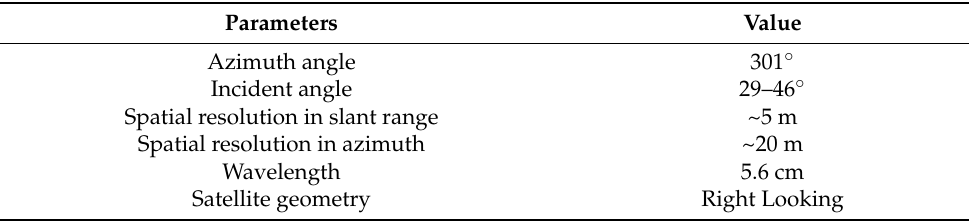
Table 2. Sentinel-1A ascending data parameters.